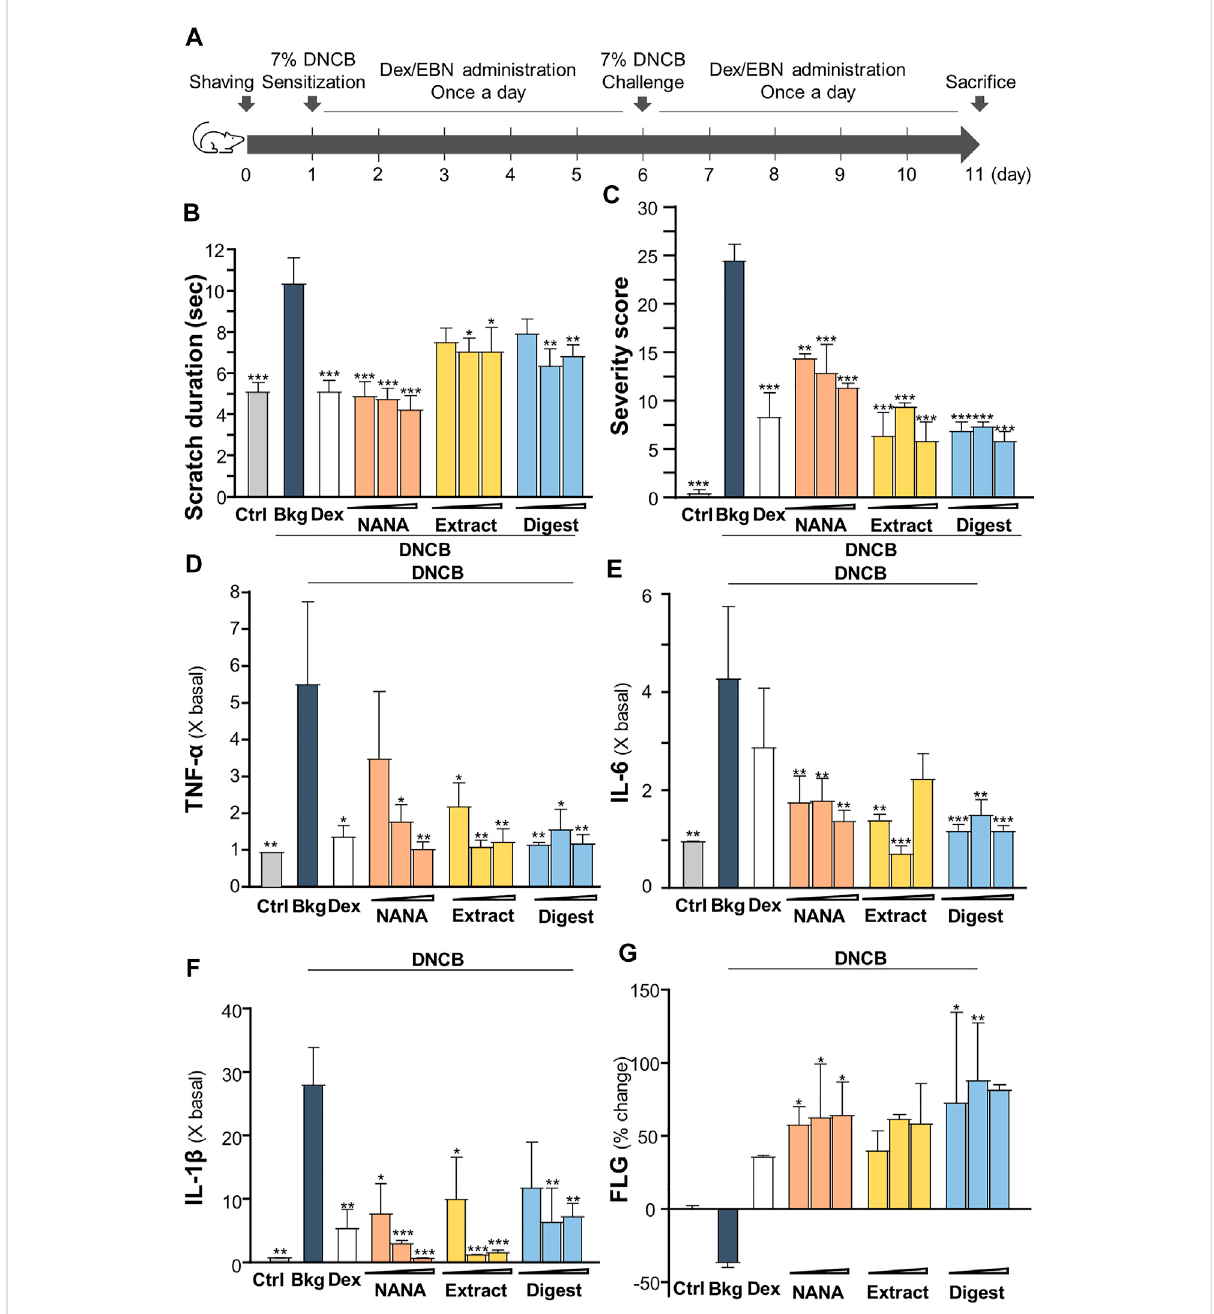
FIGURE 7 EBNameliorates thesymptomsofDNCB-induced atopicdermatitismice. (A) TimecourseofEBN treatment intheDNCB-induced micemodel isshown.Themicewereacclimatizedandshaved1daybeforechemicalsensitizationby7%DNCBondorsalskin.NANA(1,10,100 mM),EBNextract and digest (0.1, 1, 10 mg/mL) were applied daily, as indicated. Dexamethasone at 0.12% was a positive control. Re-challenge of 7% DNCB was performed on day 6. Mice were sacri fi ced on day 11. Vehicle (vaseline) only treatment was adopted as blank. (B) Scratching duration and (C) severityofdermatitiswereassesseddaily.Valuesareexpressedinmean±SEM, n =6.Thequanti fi cationsofpro-in fl ammatorycytokinesincollected skin: (D) TNF- α , (E) IL-6 and (F) IL-1 β , and (G) skin barrier fi laggrin protein (FLG) are shown. Dose dependence of NANA (1, 10, 100 mM), EBN extract anddigest(0.1,1,10 mg/mL)weredetermined,asindicated.Dexamethasoneat0.12%wasapositivecontrol.Valuesareexpressedasthefoldchange to normalized basal activity set at 1, or percentage of change to normalized basal activity set at 0%, in mean ± SEM, n = 6. Statistically signi fi cant results are marked with * p < 0.05, ** p < 0.01 and *** p < 0.001 against the DNCB-treated